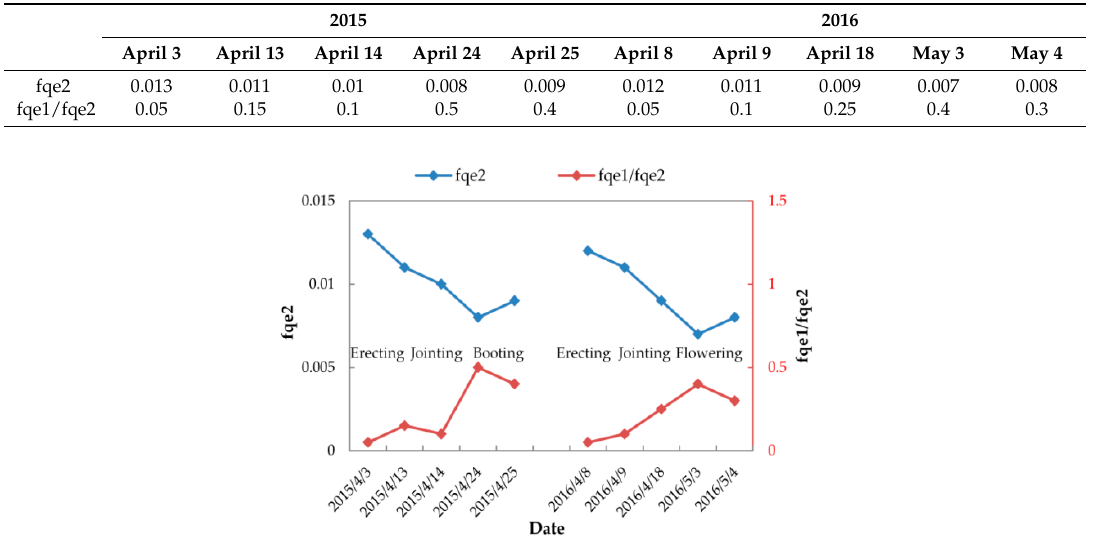
Table 6. The variable fqe2 and fqe1/fqe2 values on ten fieldwork days in 2015 and 2016.